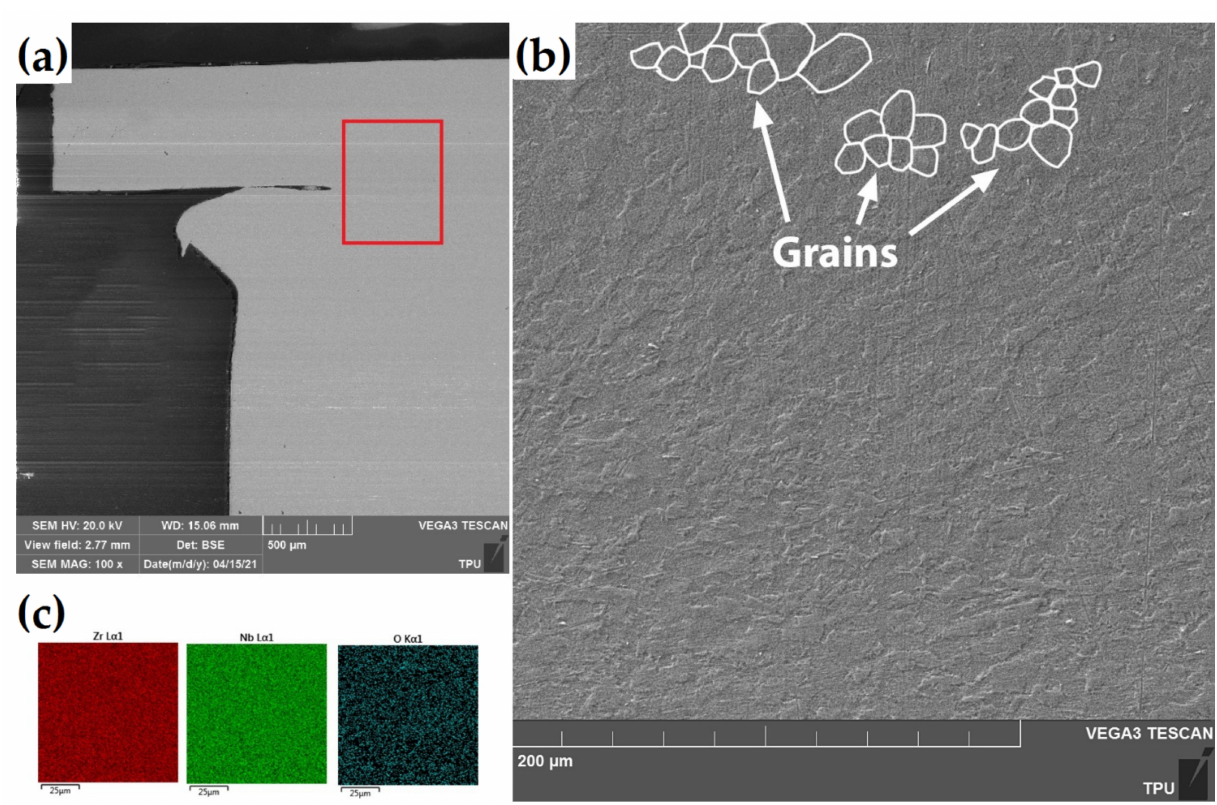
Figure 3. ( a ) The SEM images of the cross-section of the as-received RUW weld. The red square indicates measurement position at ( b ) higher resolution. ( c ) The EDS-maps of Zr, Nb and O in the welding region. There was no difference in microstructure of welding region and end plug or cladding tube. The microstructure of the weld region consists of non-equiaxed coarse grains